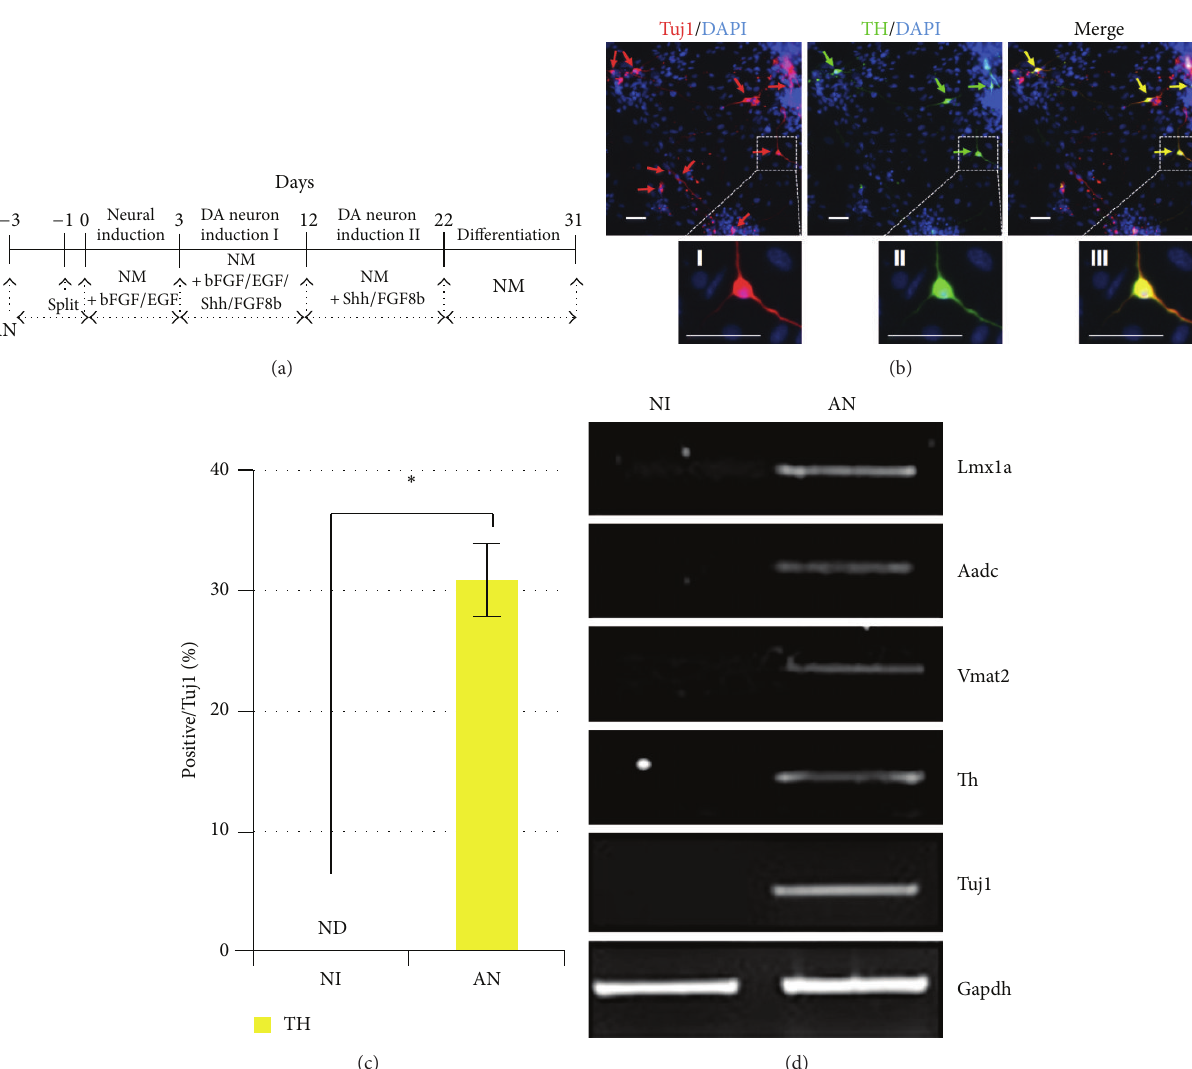
Figure 4: Direct conversion of MEF cells into dopaminergic (DA) neurons. (a) Schematic diagram of the generation of MEF-derived DA neurons. (b) Representative immunofluorescence of the DA neurons stained with Tuj1 and TH antibodies. A yellow arrow indicates DA neurons. Magnification × 200; scale bar is 50 𝜇 m. (I, II, and III) Higher magnification insert of B. (c) Reprogramming efficiency of the MEF cells into DA neuron-like cells. Single asterisk is 𝑃 < 0.01 . (d) mRNA expression of various DA neuronal marker genes by